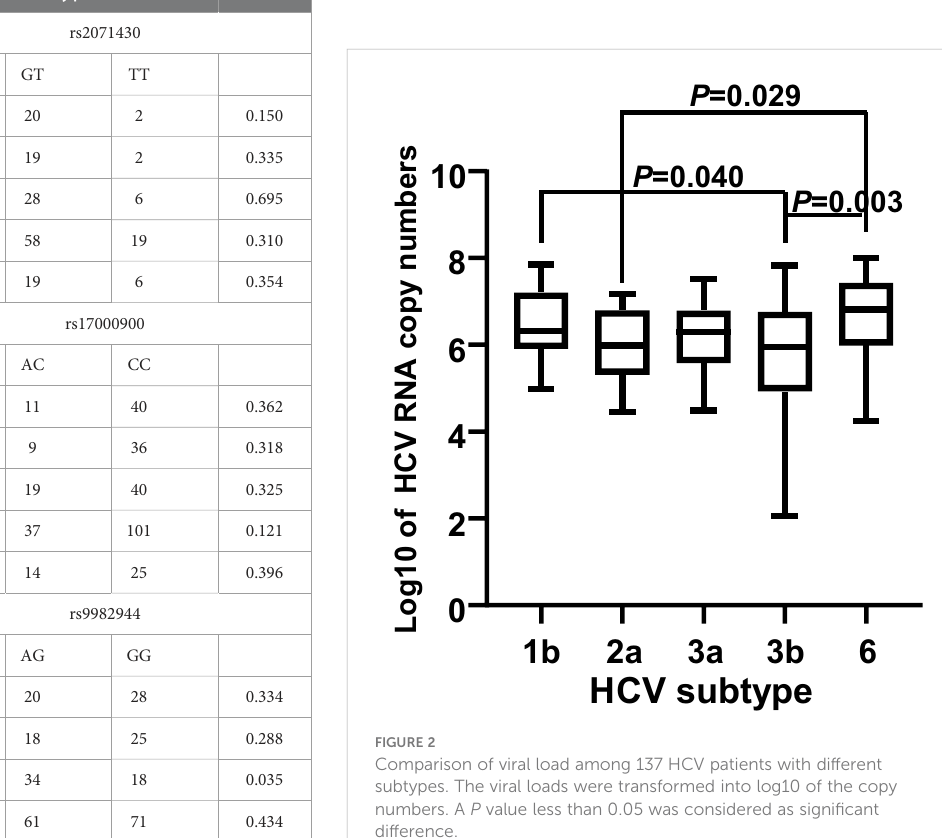
FIGURE 2 Comparison of viral load among 137 HCV patients with different subtypes. The viral loads were transformed into log10 of the copy numbers. A P value less than 0.05 was considered as signi fi cant difference.